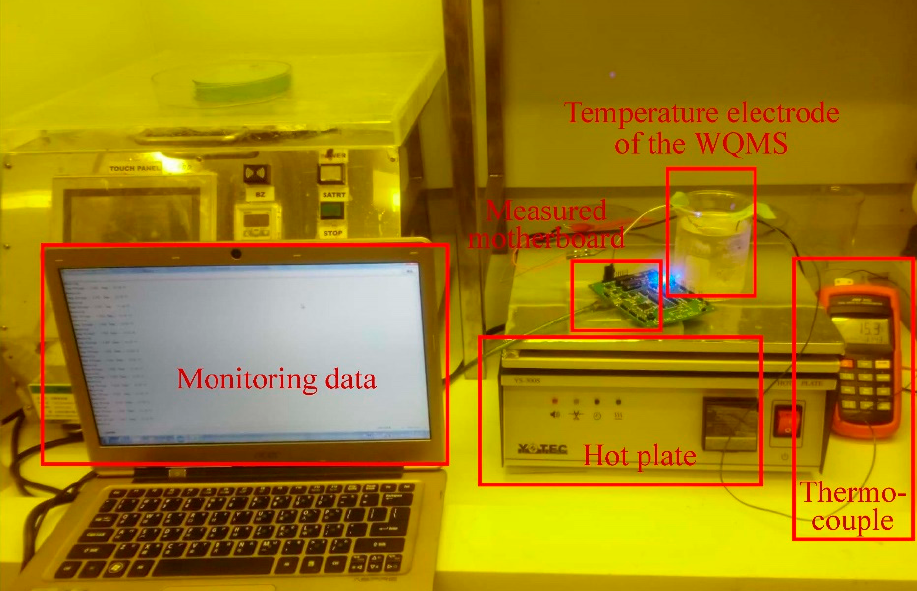
Figure 4. The experimental setup for measuring temperature.